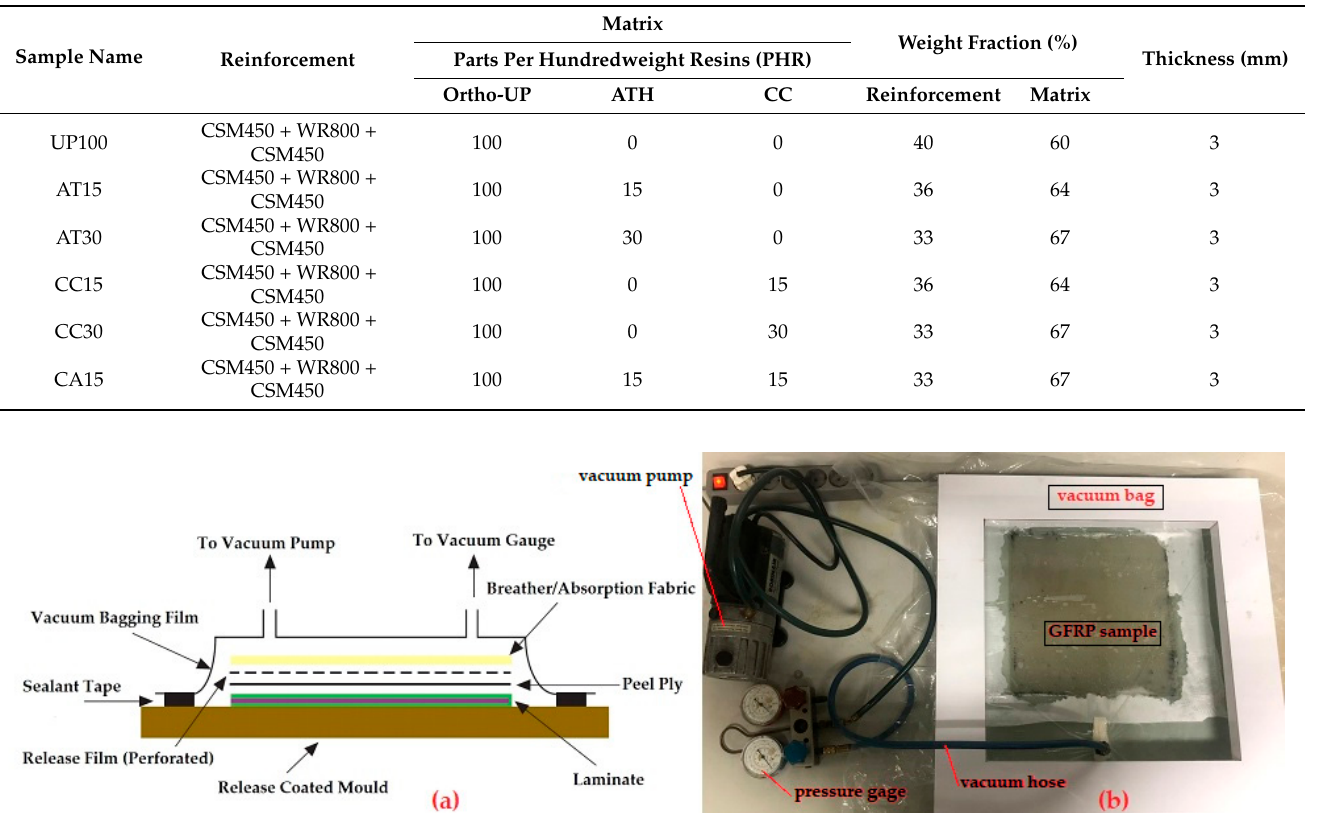
Table 1. The GFRP composite samples.